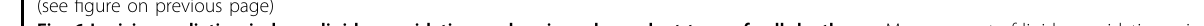
Fig. 6 Ionizing radiation induces lipid peroxidation and an iron-dependent type of cell death. a – c Measurement of lipid peroxidation using C11-BODIPY probe and cell death using Sytox Blue in CT26 ( a ), MCA205 ( b ), and 71-7 ( c ) cells 24 h after irradiation with 20 or 50 Gy. Increase in lipid peroxidation can be seen in the fi rst left quadrant by the shift of C11-BODIPY fl uorescence measured after 20 Gy (blue) or 50 Gy (red) X-rays. When indicated, the cells were pre-treated with iron chelators CPX and DFO, or with antioxidants vitamin E and Fer-1 1 h before irradiation. Quanti fi cation of cell death is shown as percentage for CT26 ( a ), MCA205 ( b ), and 71-7 ( c ). Means ± SEM are shown ( n = 2 – 3). A two-way ANOVA was performed with a Tukey ’ s multiple comparisons test. Asterisks (*) show the comparison to 20 Gy Methuosis. * p ≤ 0.05, ** p ≤